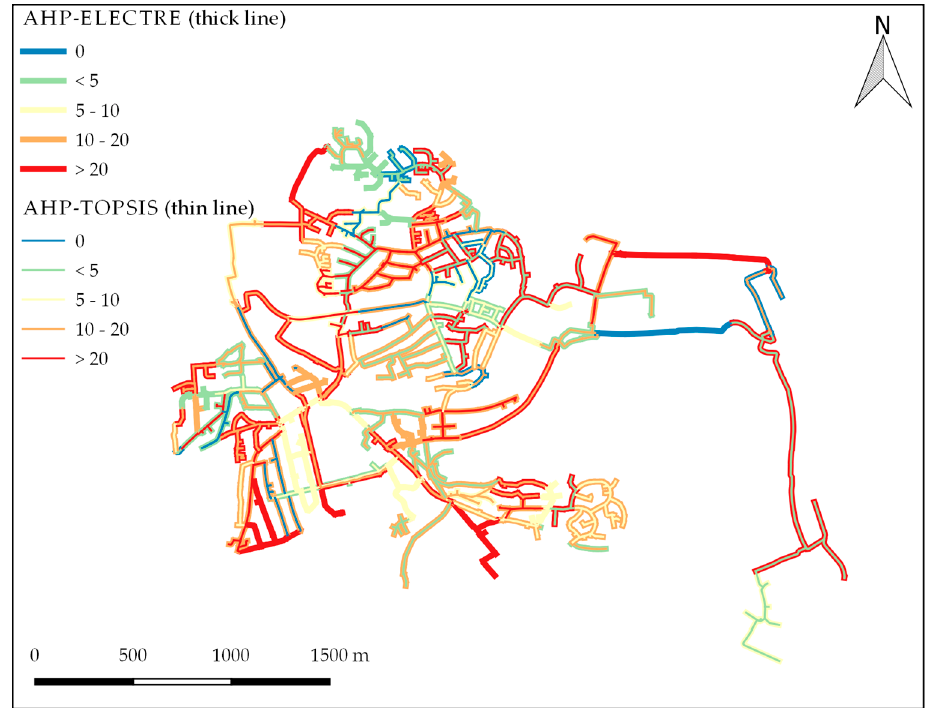
Figure 12. Comparison of the rankings of the gas distribution system between TOPSIS (thin line) and ELECTRE (thick line) with the results from AHP.